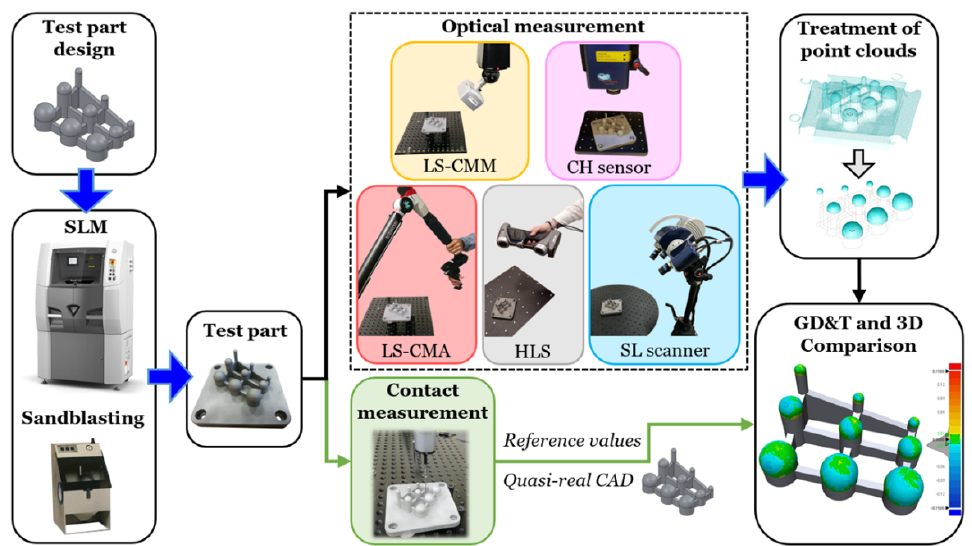
Figure 1. Methodology evaluating a selective laser melting (SLM) test part using different optical